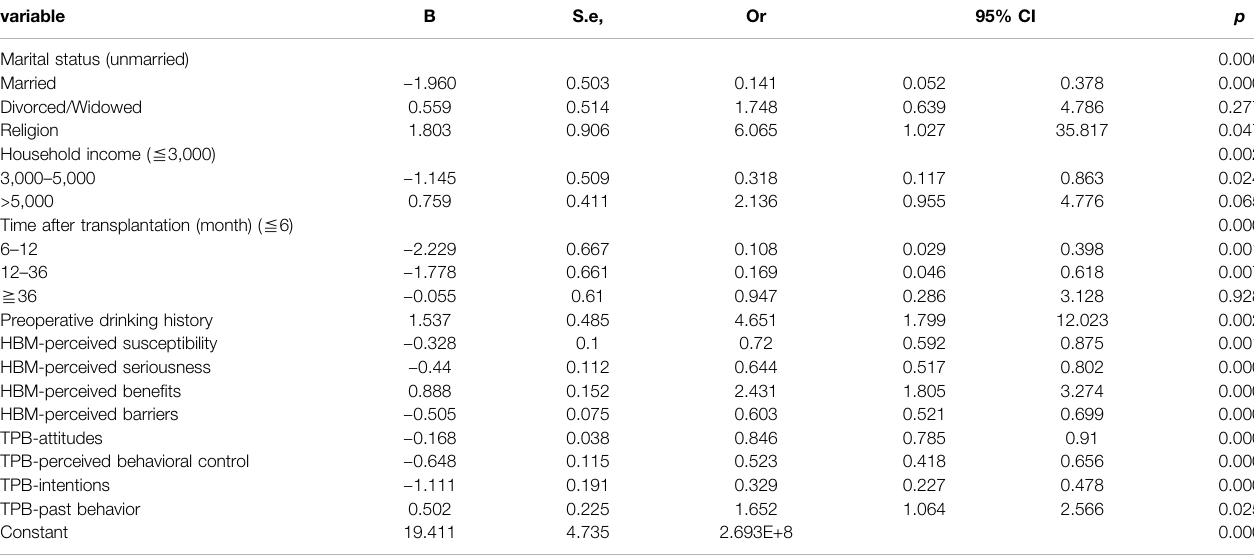
TABLE 4 | Binary logistic regression analysis of the association between sociodemographic characteristics and IM adherence among RTPs. variable B S.e, Or 95% CI